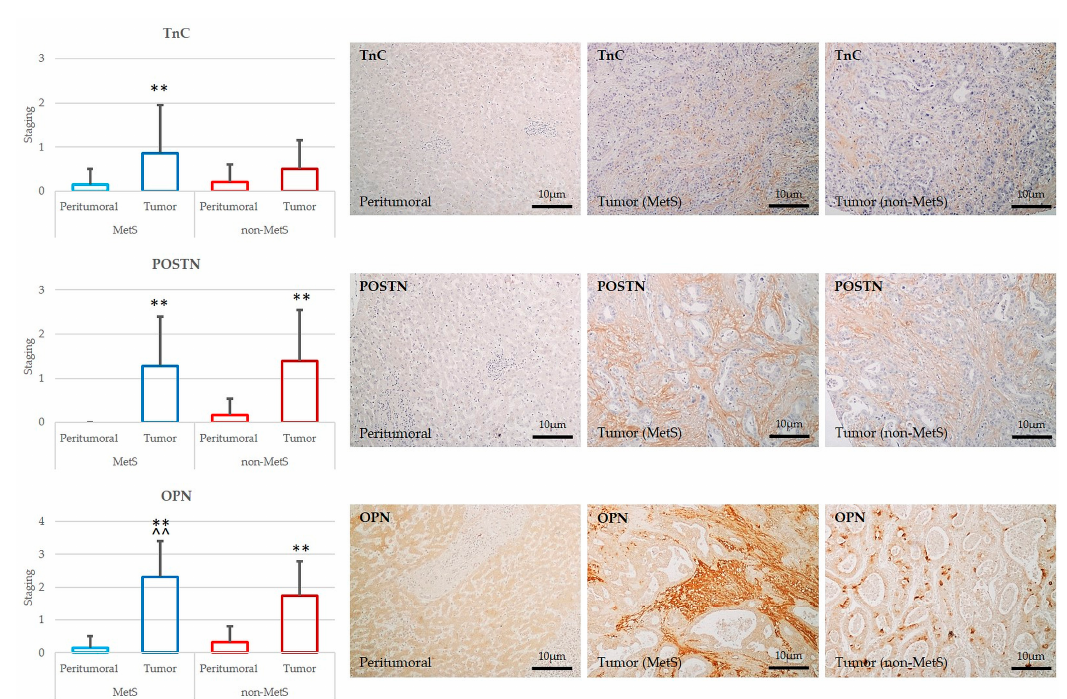
Figure 4. POSTN, TnC, and OPN were more expressed in tumoral than in peritumoral areas of iCCA in either MetS or non-MetS, and OPN overexpression characterized MetS iCCA. The left-sided column plots showed that the deposition of all the three ECM proteins was increased in the bulk tumor compared to the matched peritumoral area in both MetS (n = 22) and non-MetS (n = 44) patients. Notably, OPN overexpression in the TRS discriminated MetS from non-MetS iCCA. ** p < 0.01 vs. relative peritumors; ^^ p < 0.01 vs. non-MetS iCCA using one-way Analysis of Variance (ANOVA) test.